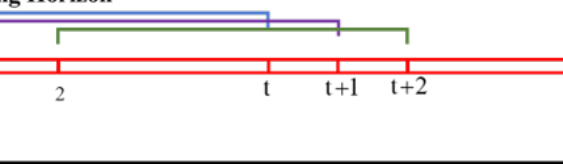
Figure 5. LSTM-MILP-RH flow model for real-time operation of the grid-connected CHP system (online optimisation). This paper uses MILP to model the system under consideration as an economic load dispatch optimisation problem over a period of 24 h consisting of 48-time steps (every half hour). For the future time horizon, the LSTM makes projections for both PV generation and load data. After that, the MILP and RH control strategy are applied to solve the eco- nomic dispatch problem [17]. Only the dispatch command for the real-time (first-time step) is applied to the CHP Units and BESS, and the process is repeated.